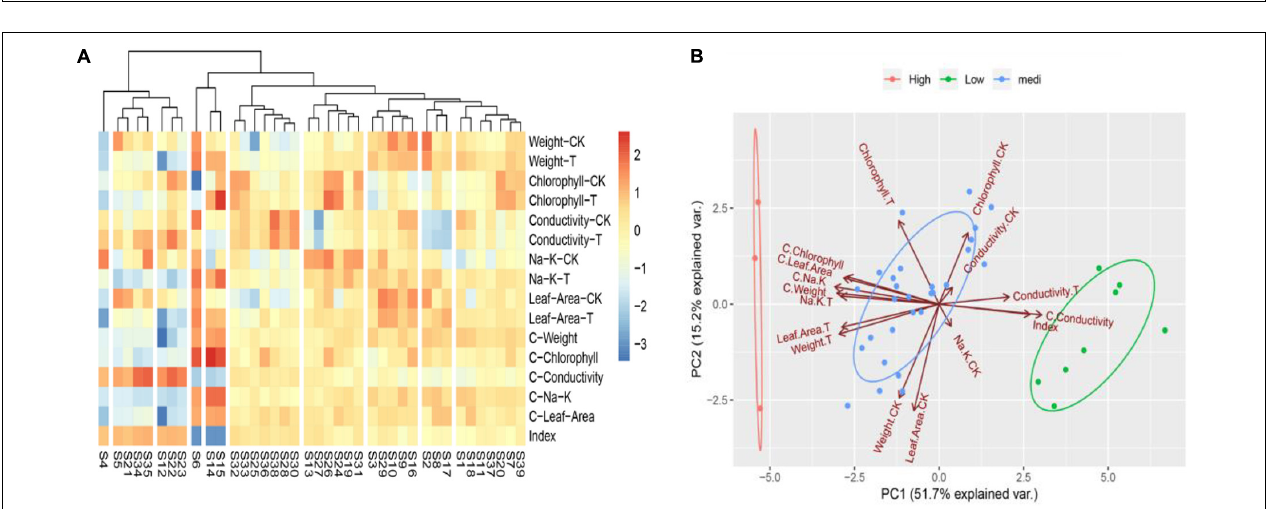
FIGURE 1 | Cluster analysis of salt tolerance of Chinese cabbage. (A) Clustering of salt injury index in seedling stage. (B) Clustering of salt injury index in rosette stage. (C) Clustering of salt injury index during heading stage. (D) Relative value of fresh weight, electrolyte leakage relative value clustering in seedling stage.